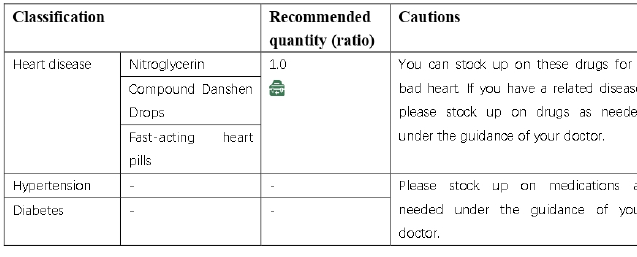
Figure 20. Final practical domestic-medication system.